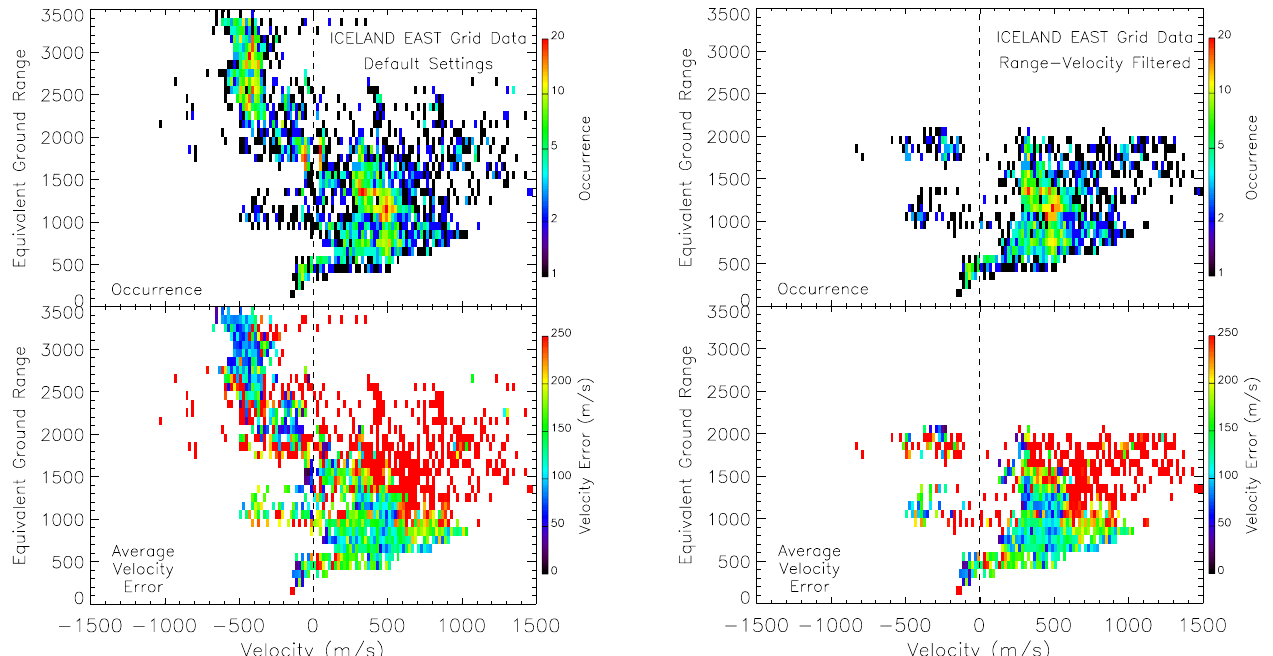
Fig. 12. Gridded velocity distribution for the Iceland East radar for the interval 13:00–14:16 UT on 11 February 1998, using (a) the default processing, and (b) velocity-range gate filtering. Also shown is the average velocity error measured in each distribution